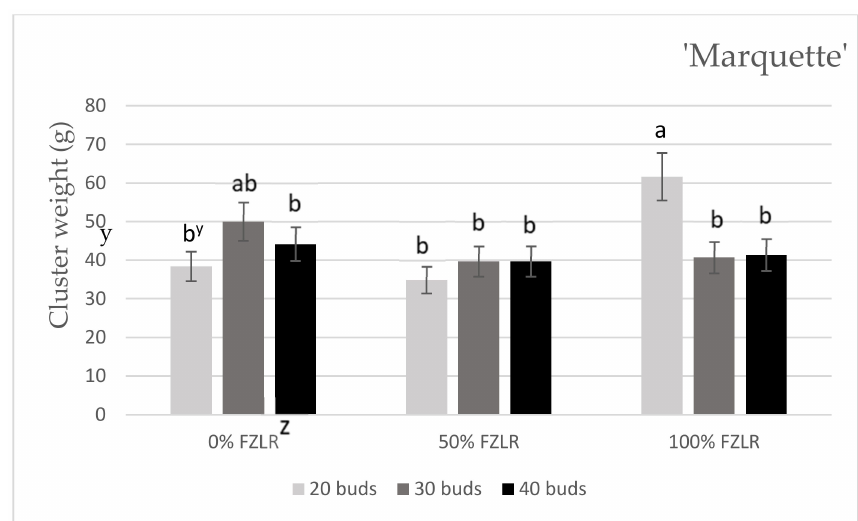
Figure 2. E ff ect of grape cultivar, bud retention, and fruit-zone leaf removal percentage on cluster weight of two V. riparia -based cultivars averaged over locations and years; z Abbreviation FZLR = fruit-zone leaf removal; y Means followed by the same letter(s) are not significantly di ff erent according to Duncan’s multiple range test at p < 0.05. Table 6. E ff ect of fruit-zone leaf removal on cluster weight at harvest for two V. riparia -based cultivars averaged over primary bud retention levels, locations, and years. Leaf Removal Percentage Frontenac Gris